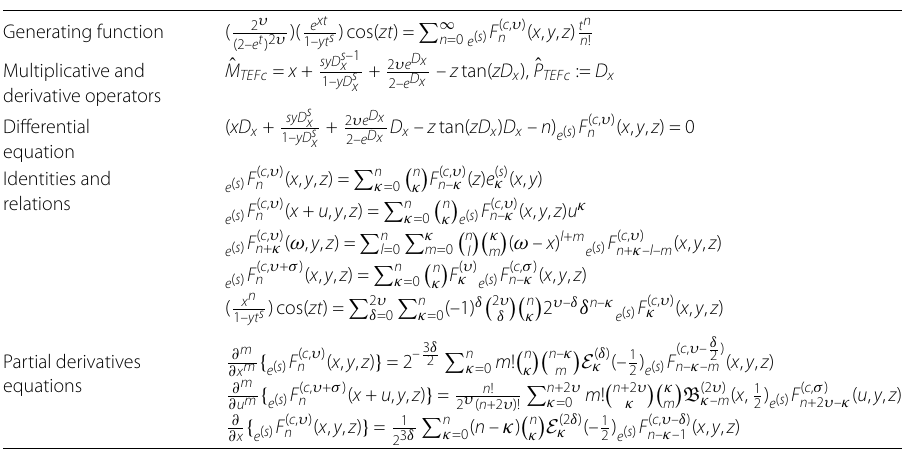
F ( c , υ ) n ( x , y , z ) e ( s )